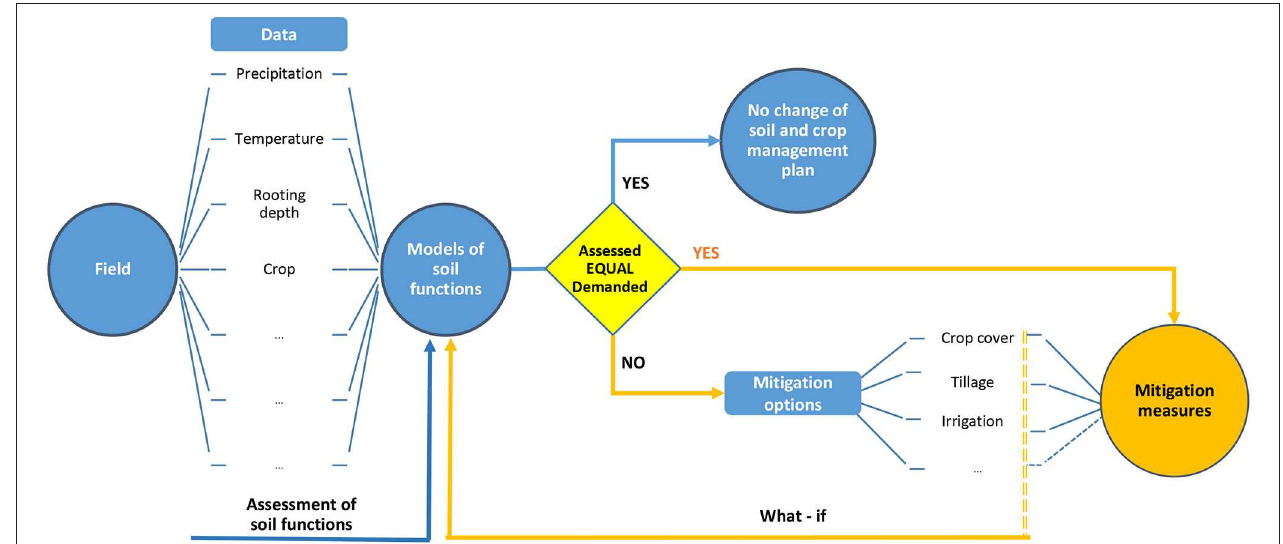
FIGURE 3 | Conceptual representation of the Soil